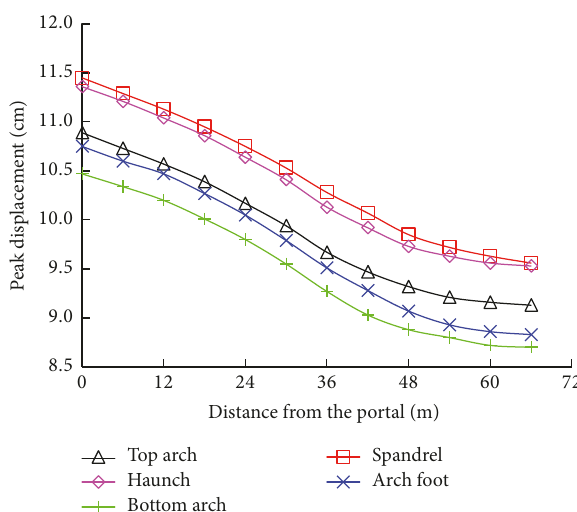
Figure 7: 𝑥 -peak displacements variation of monitoring points along tunnel axis.